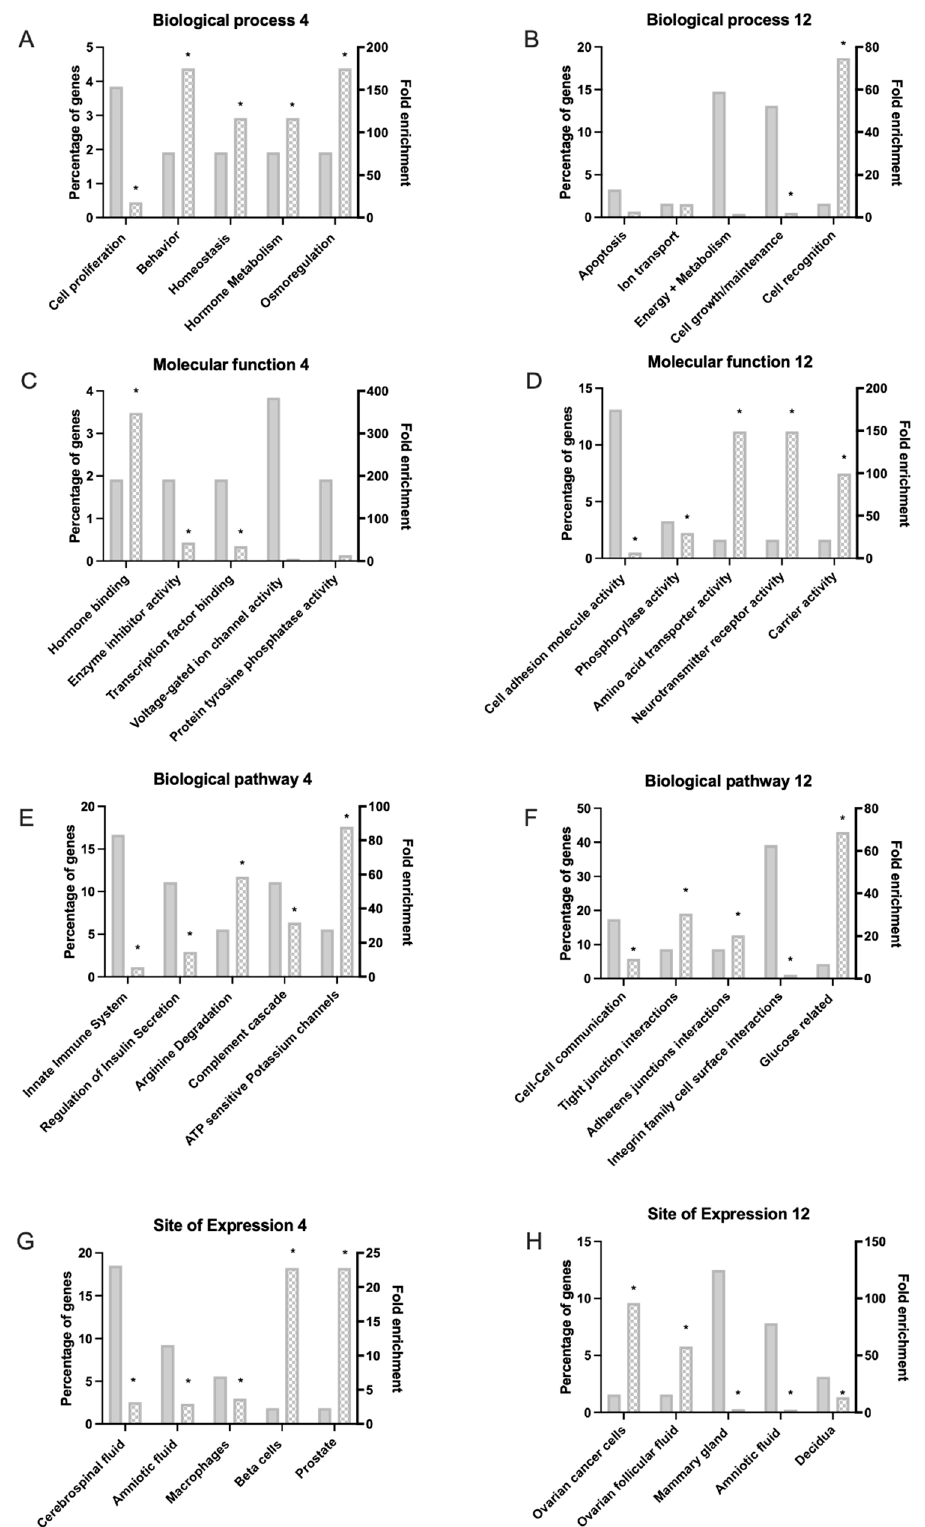
Figure 3. Functional enrichment of differentially expressed genes (DEGs) matched with Funrich data base. ( A , C , E , G ) indicate altered process 4 h after treatment with 100 nM asprosin; ( B , D , F , H ) show processes associated with DEGs 12 h after treatment. ( A , B ) Biological process; ( C , D ) Molecular function; ( E , F ) Biological Pathway; ( G , H ) Site of expression. Significant data sets identified using hypo geometric test are indicated by * p < 0.05.